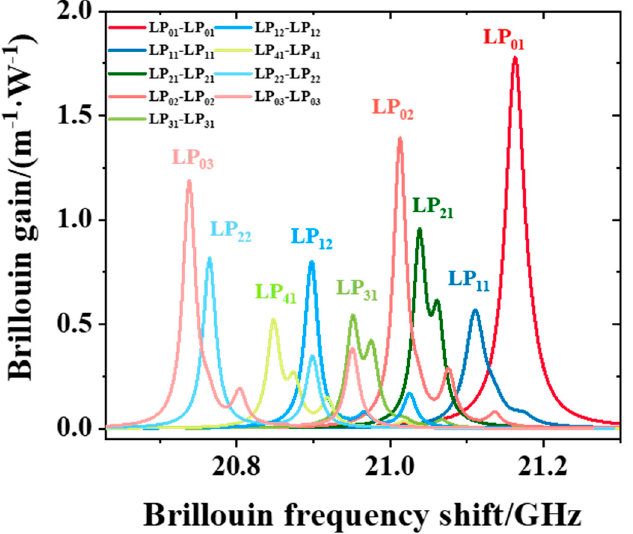
Figure 6. In the case of nine LP mn -LP mn mode pairs, the total Lorenz curve of each LP mn -LP mn mode pair to BGS.